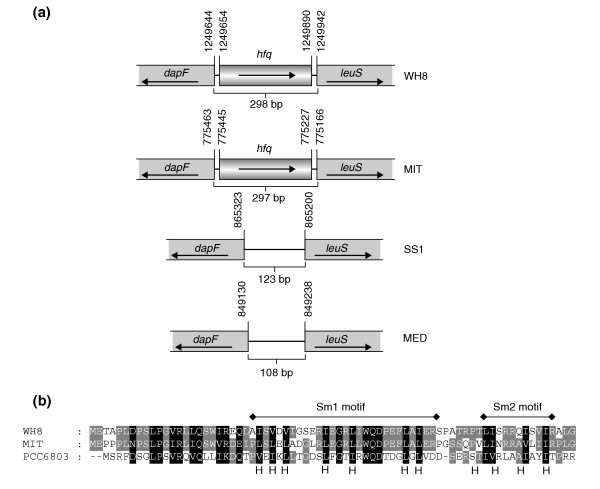
A putative gene encoding the RNA chaperone Hfq can be predicted in two of the four marine cyanobacteria investigated here. (a) The dapF-leuS intergenic region in Synechococcus WH 8102 (WH8) and Prochlorococcus MIT 9313 (MIT) is, at 298 and 297 nucleotides, respectively, relatively long and contains a short reading frame for a putative hfq gene. In Prochlorococcus SS120 (SS1) and MED4 (MED), this region is only 123 and 108 nucleotides, respectively. (b) Sequence comparison of putative Hfq proteins from the three cyanobacteria Synechocystis PCC 6803 (ssr3341 gene), Synechococcus WH 8102 (WH8) and Prochlorococcus MIT 9313 (MIT). Hydrophobic residues within the Sm1 and Sm2 motifs [29] are indicated by an H.